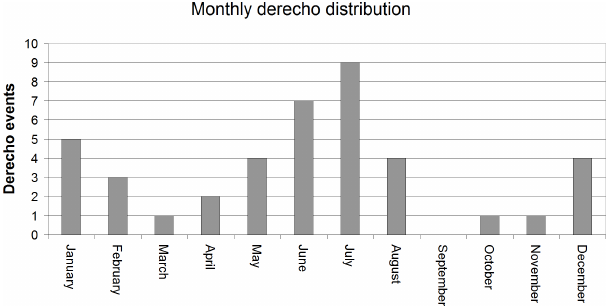
Figure 3. Seasonal distribution of derecho events in Germany